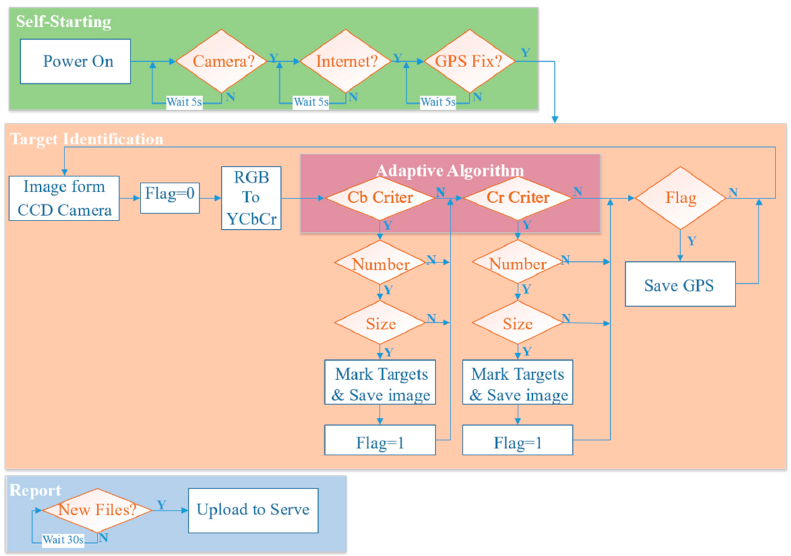
Figure 8. Flowchart of the on-board target identification system.